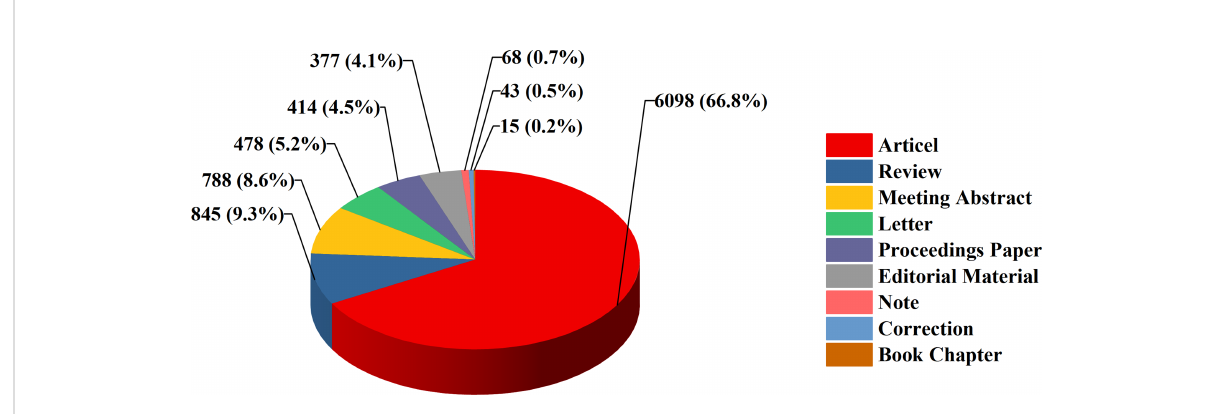
FIGURE 2 Lymphedema research papers by document type percentage.